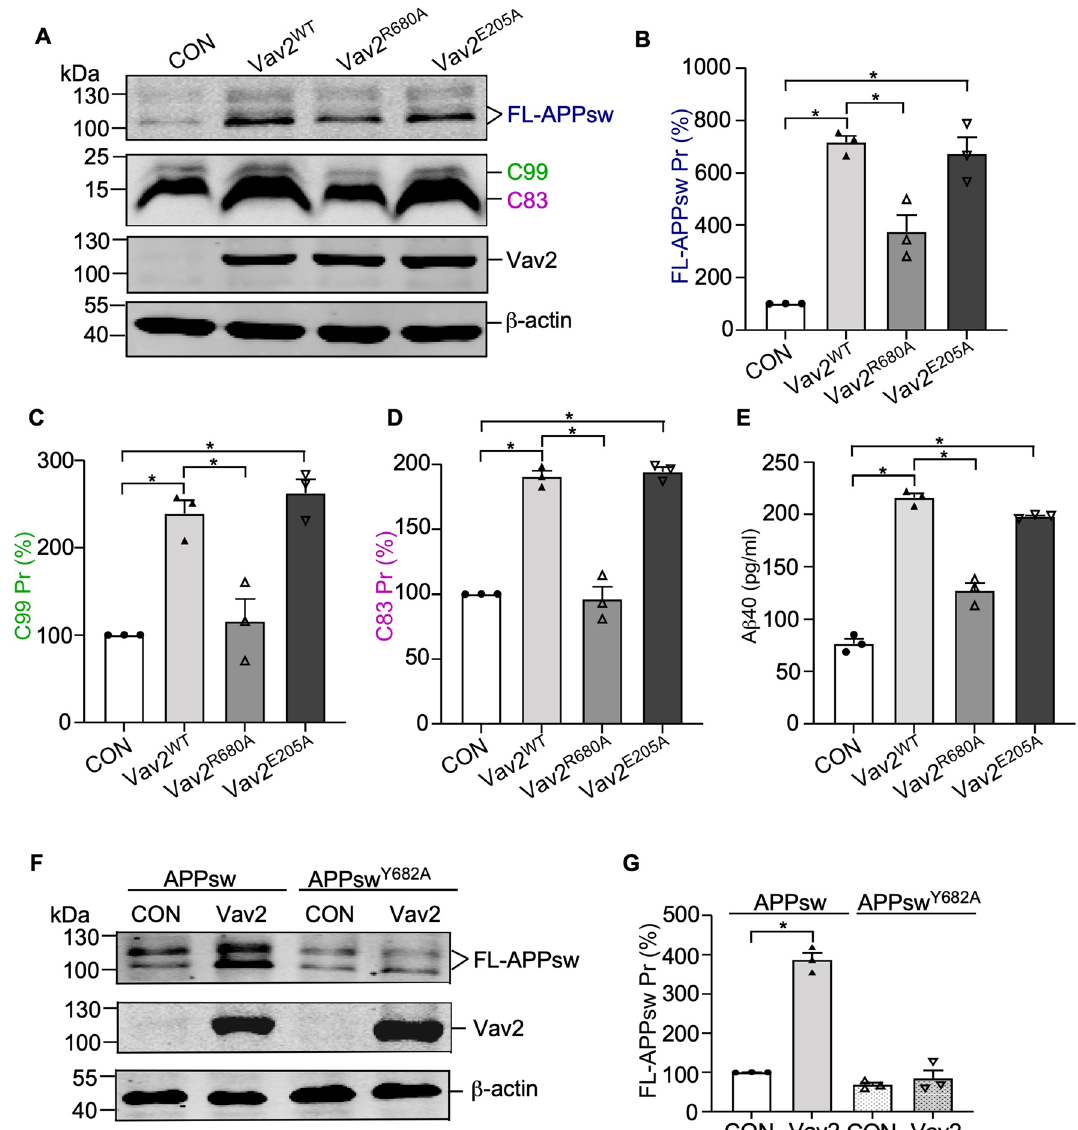
Figure 5. Vav2 upregulates the APP protein level and Aβ40 production. ( A ) Vav2 regulates the protein level of APP, C99 and C83 in 20E2 cells. 20E2 cells were transfected with Vav2 WT , Vav2 R680A , Vav2 E205A and empty control, respectively. Vav2, FL-APPsw, C99 and C83 protein levels were examined by Western blot, β-actin was used as loading control. Original blots are presented in Supplementary Figures. ( B – D ) Quantification of ( A ) using ImageJ software. All quantified results were obtained from three independent experiments. Data were presented as means ± SEM (n = 3); * p < 0.05, p values were calculated by Student’s t test. ( E ) Elisa was performed to measure Aβ40 in culture media from 20E2 cells transfected with Vav2 WT and its mutations, respectively. All quantified results were obtained from three independent experiments. Data were presented as means ± SEM. (n = 3); * p < 0.05, p values were calculated by Student’s t test. ( F ) HEK293 cells were co-transfected with APPsw or APPsw Y682A in the presence or absence of Vav2. Western blot was performed to detect the level of FL-APPsw protein level. β-Actin was used as loading control. ImageJ software was used for quantification. Original blots are presented in Supplementary Figures. All quantified results were obtained from three independent experiments. Data were presented as means ± SEM (n = 3); * p < 0.05, p values were calculated by one-way ANOVA with Bonferroni’s multiple comparisons post hoc